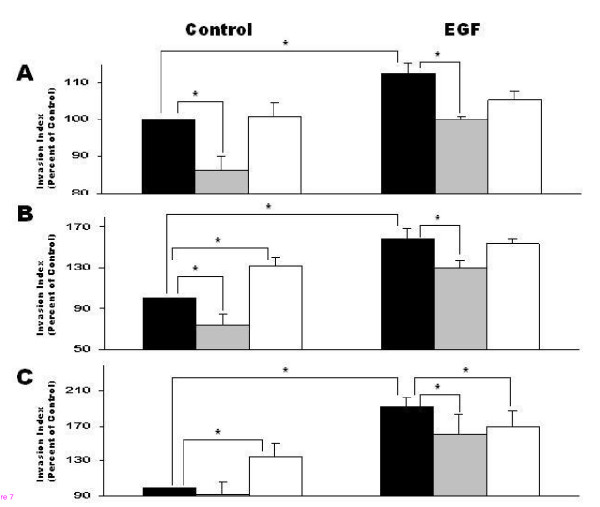
Cell invasion ability of JAR cells, 1st trimester trophoblast cells 6–8 week or 1st trimester trophoblast cells 9–12 week tested with Transwell Invasion Assay. (A) represents JAR cells, (B) 1st trimester trophoblast cells 6–8 week and (C) 1st trimester trophoblast cells 9–12 week. Cells were treated with 8 ng/ml EGF and incubated 36 hours on Matrigel coated membrane, with or without MMP-2 or MMP-9 inhibitory antibodies. Cells that invaded the membrane to lower well were counted with XTT. Results represent mean +SEM from 10 independent experiments. Black bars represent control (cells without treatment or cells treated with EGF) with no antibodies. Gray bars represent cells (without treatment or EGF treated) with addition of MMP-2 inhibitory antibody. White bars represent cells (without treatment or EGF treated) with addition of MMP-9 inhibitory antibody. ANOVA for all groups results in p < 0.05, post test confirmed the t test results. * P < 0.05.